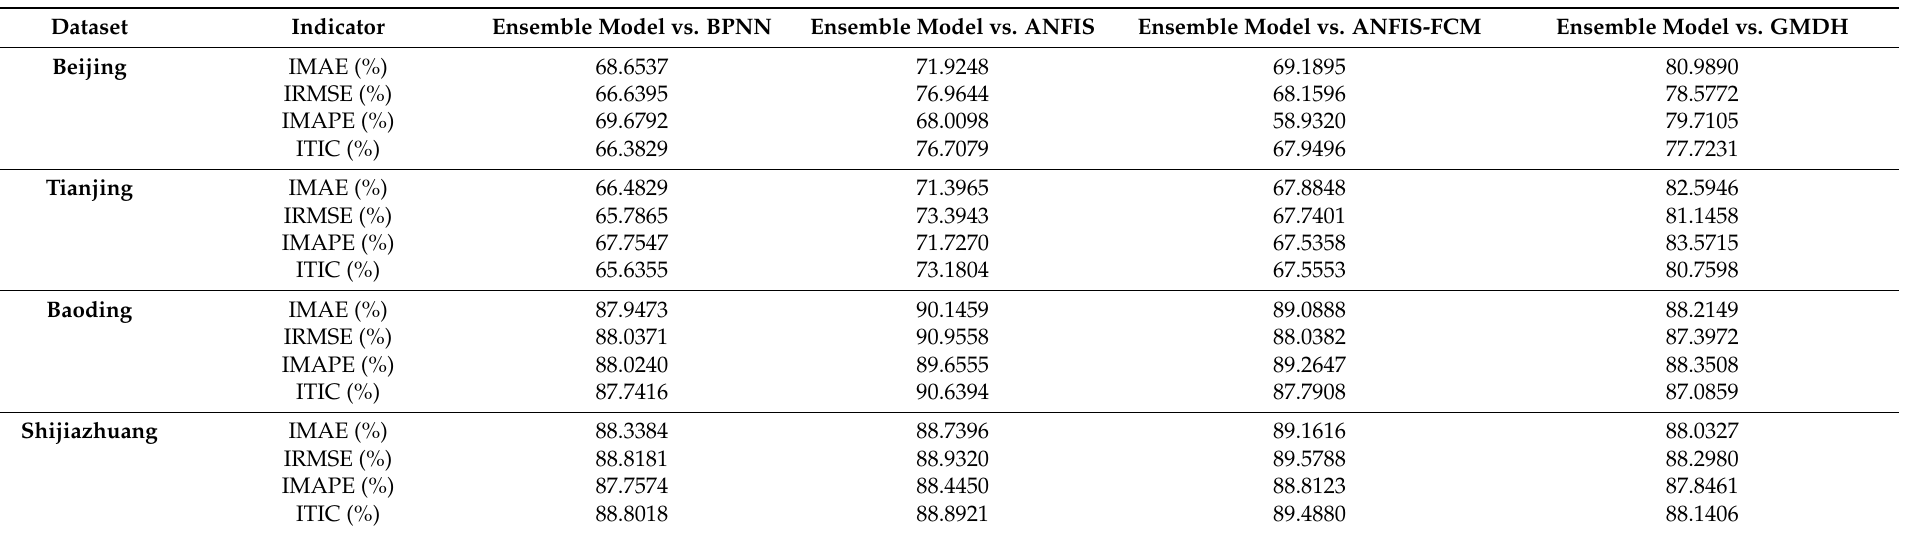
Table 5. The results of the ensemble model and other single models at four